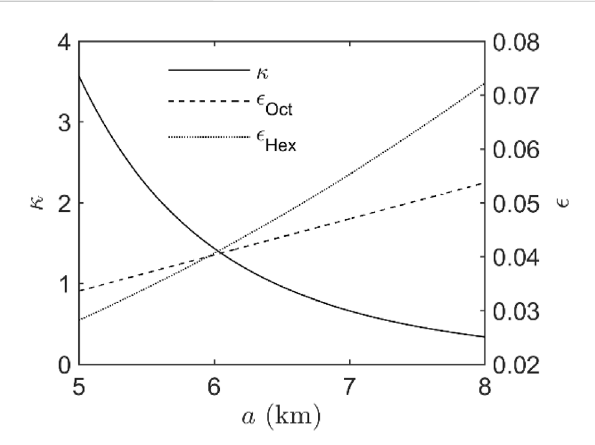
FIGURE 3 Coef fi cients of κ (left y -axis), and ε Oct ; ε Hex (right y -axis) with semimajor